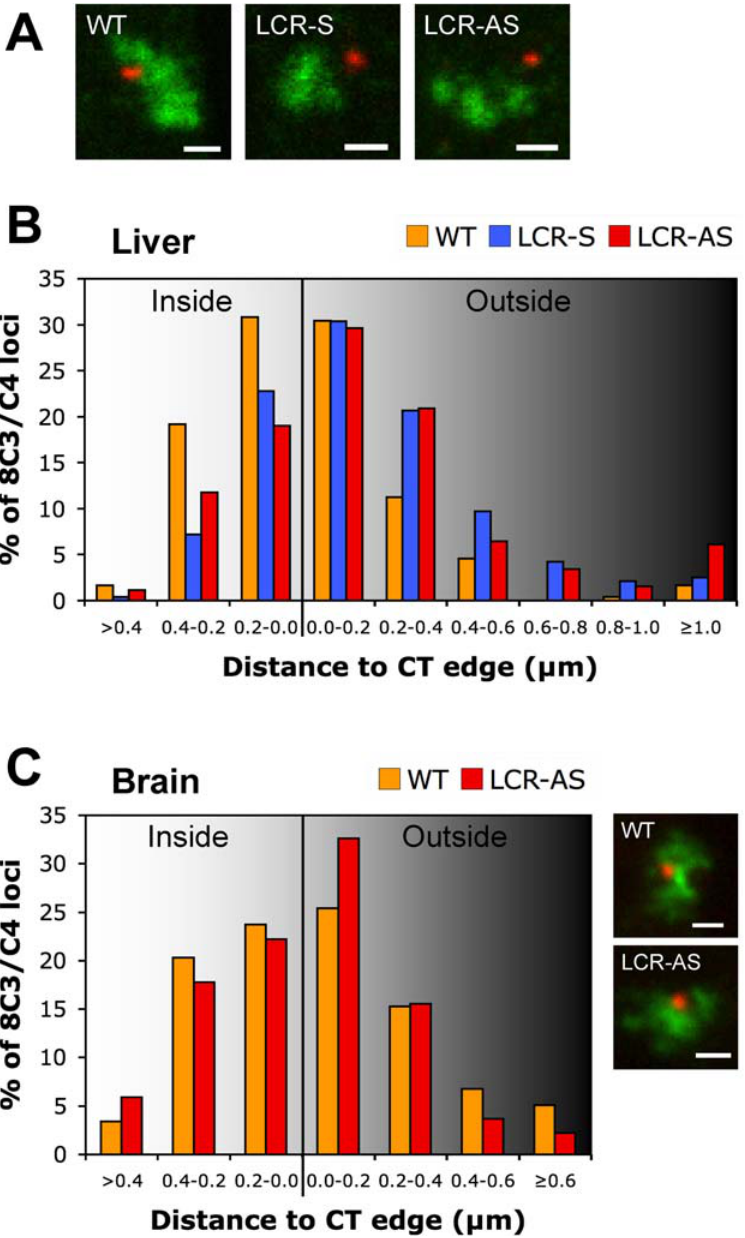
Figure 3. Effect of LCR insertion on the positioning of 8C3/C4 in relation to its CT. (A) Cryosections from WT, LCR-S and LCR-AS fetal liver nuclei were hybridized to a BAC probe containing the 8C3/C4 locus (red) and a chromosome 8 specific paint (green). Bars, 1 m m. (B) After cryo-FISH, the distances from the center of each locus to the nearest CT edge were measured (n $ 237 loci). Statistically significant differences were found between the wild-type locus and both transgenic loci containing the LCR (p , 0.001, K-S test). (C) Distances between 8C3/C4 and the CT edge were measured for sections from WT (n=59 loci) and LCR-AS (n=135 loci) fetal brain, showing no differences between the two populations (p=0.45, K-S test). Bars, 1 m